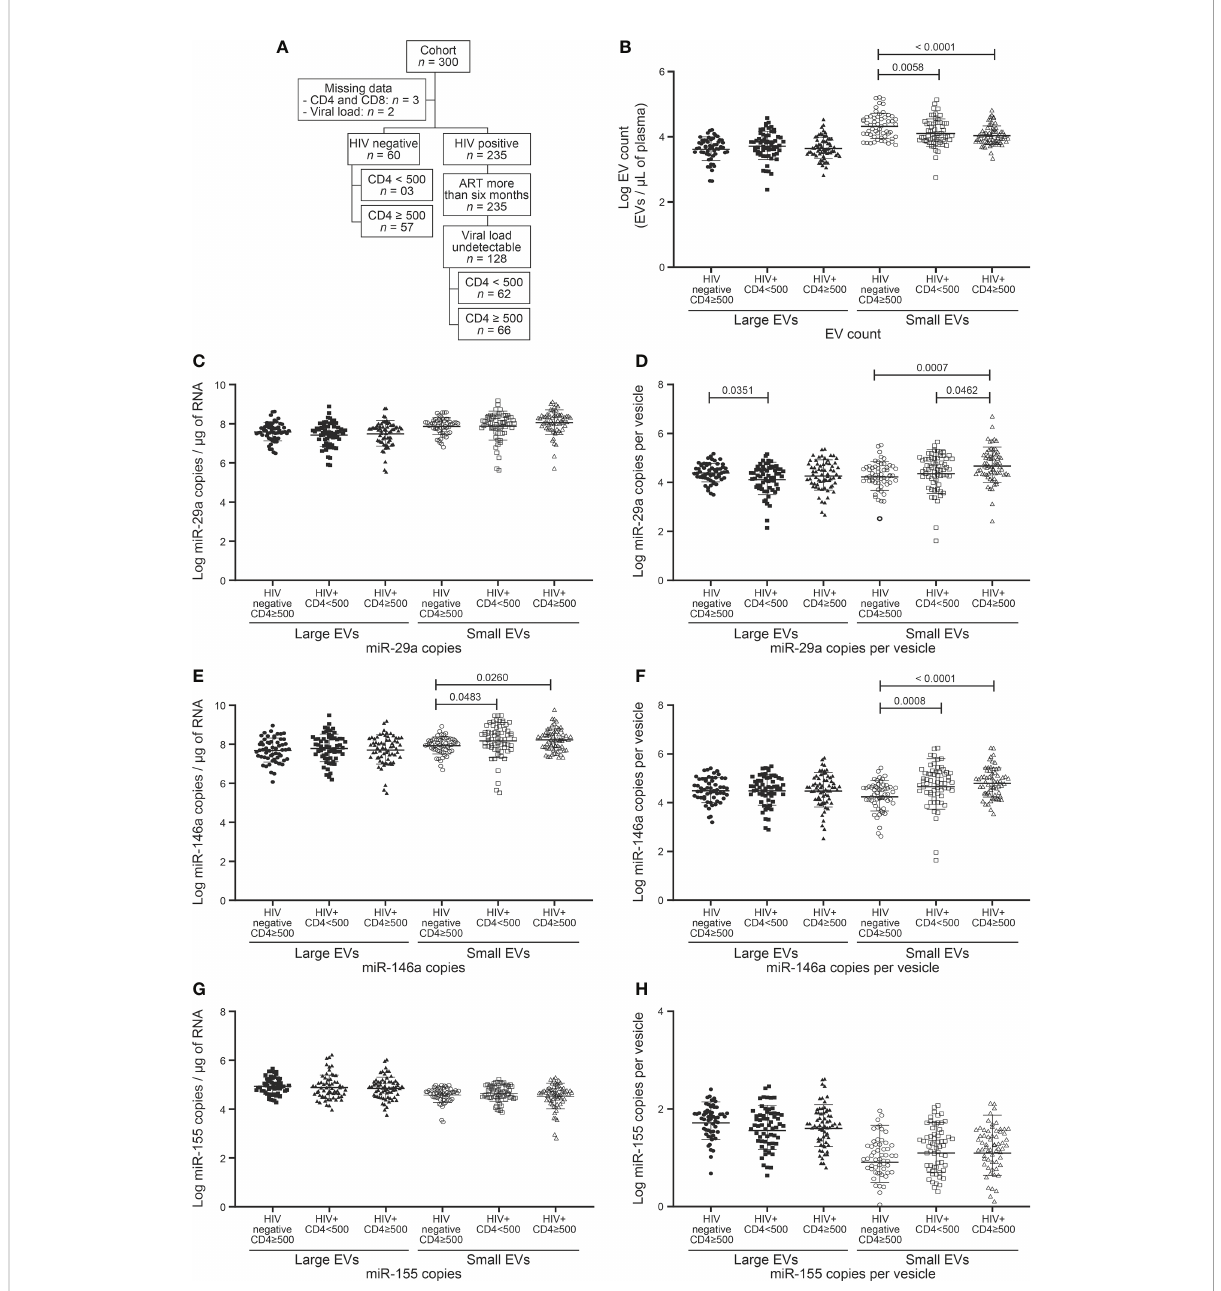
FIGURE 1 EVs count and miRNAs expression in HIV negative and HIV infected with undetectable viral load study participants follow to CD4 T cells count. (A) Flow chart of study participants included in the analysis following CD4 T cells count. (B) Large and small EVs particles number quanti fi cation in fl ow cytometry analysis. (C, D) , (E, F) , and (G, H) present respectively EVs miR-29a, miR-146a, and miR-155 quanti fi cation and expression as copies per µg of RNA and copies per vesicle. An ordinary one-way ANOVA with Tukey ’ s multiple comparisons test was used for comparison between